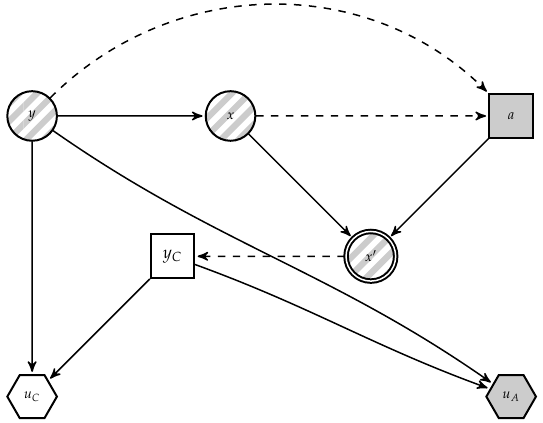
Figure 2. Adversarial classification as a Bi-agent Influence Diagram